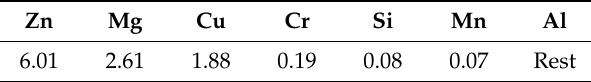
Table 1. Tested alloy composition (%